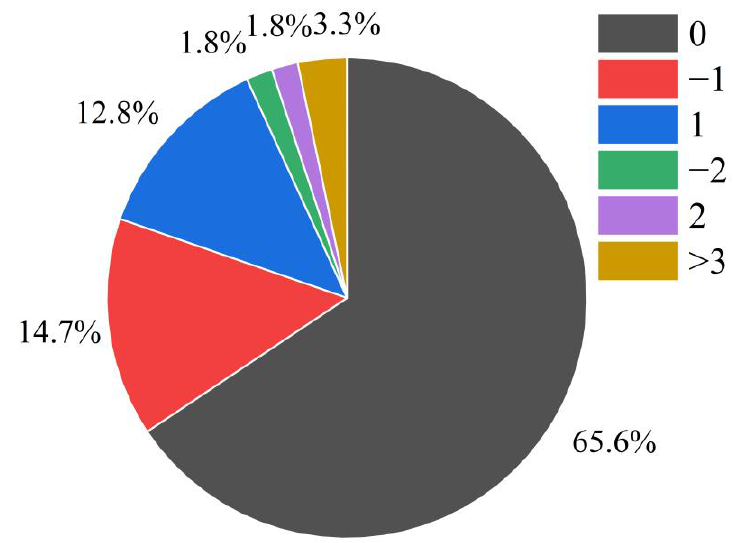
Figure 14. Statistics of the peak offset of the original LEMP waveform and the reconstructed wave- form.